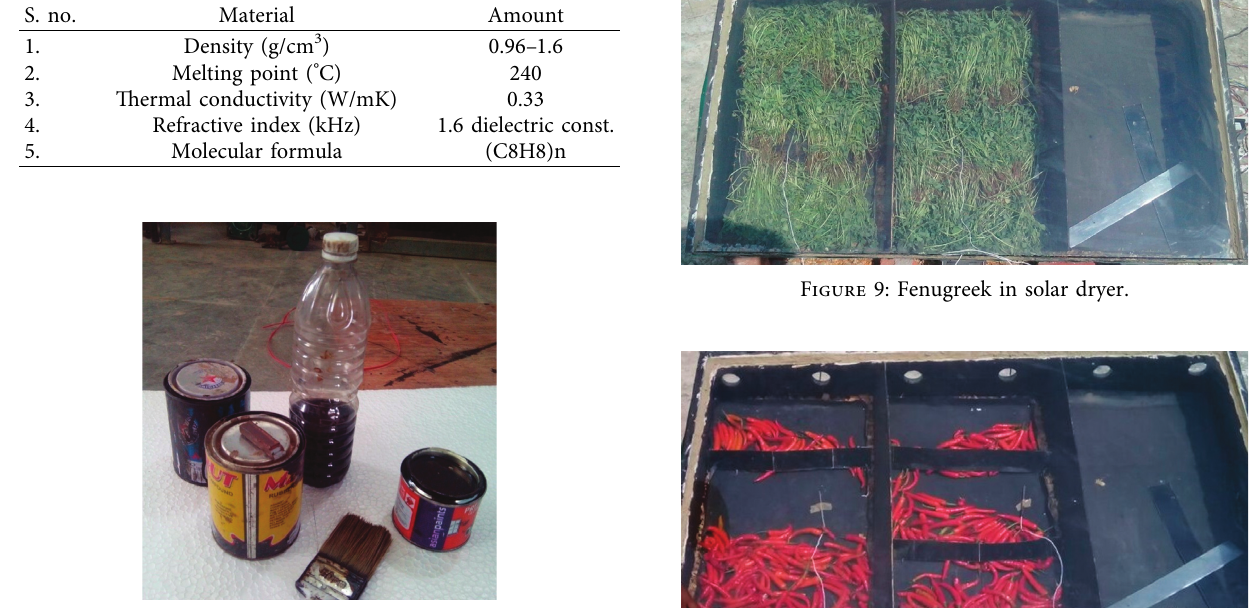
Figure 8: Paints used in the solar dryer.